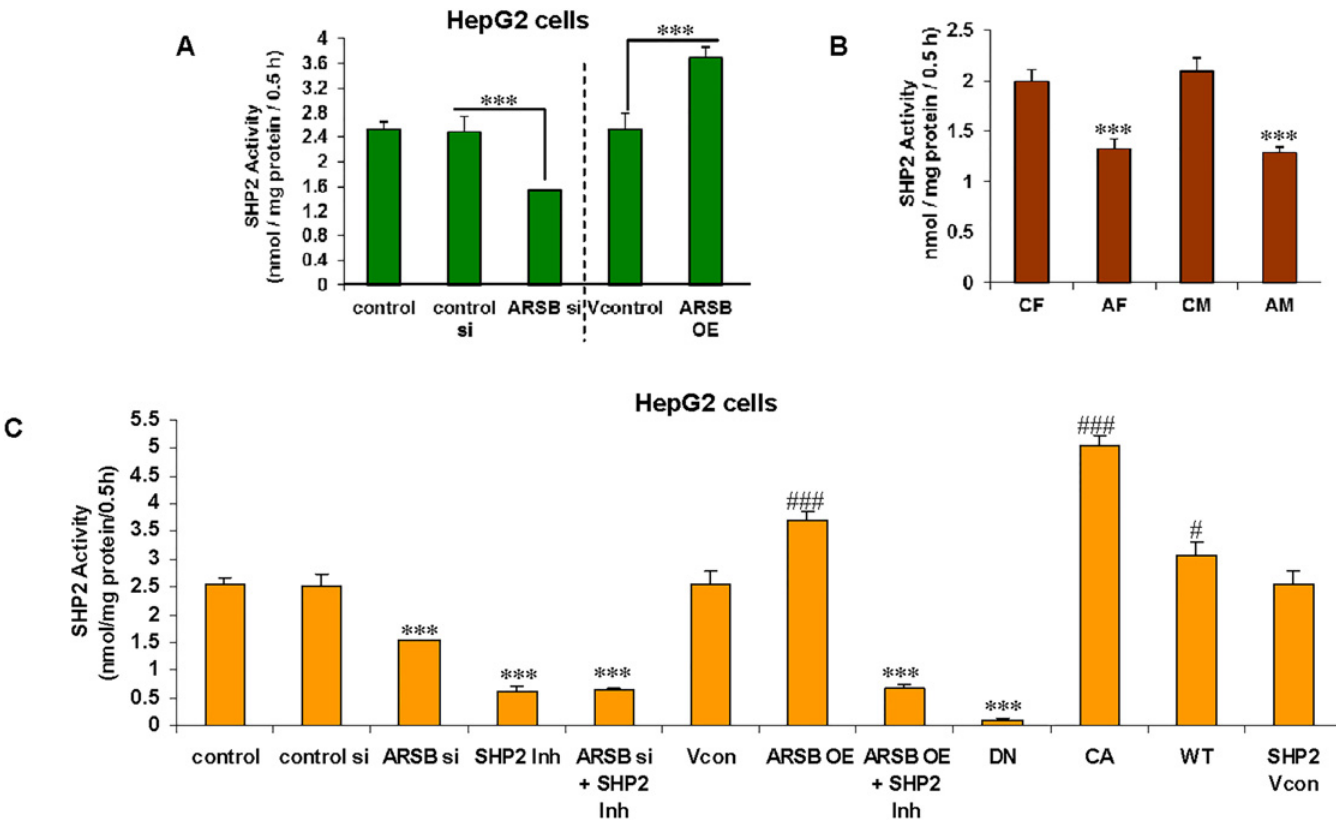
Fig 4. Decline in SHP2 activity follows decline in ARSB in HepG2 cells and in ARSB-null mice. (A) The SHP2 activity declined ~36% from (2.49 ± 0.15 nmol/mg protein/0.5 h to 1.59 nmol/mg protein/0.5h) following ARSB silencing (p < 0.001; n = 6), and increased to 3.70 ± 0.16 nmol.mg protein/0.5h when ARSB was overexpressed in the HepG2 cells (p < 0.001; n = 3). (B) SHP2 activity was markedly reduced in the ARSB-null mice (declining from 1.99 ± 0.12 to 1.33 ± 0.10 nmol/mg protein/0.5h, p = 0.001 (F); and 2.09 ± 0.13 to 1.28 ± 0.06 nmol/mg protein/h, p = 0.0006 (M), unpaired t-test, two-tailed; n = 3 per group). (C) The impact of different SHP2 DNA constructs on the SHP2 activity was tested. Constitutively active(CA)- and wild-type(WT)-SHP2 DNA increased the SHP2 activity (p < 0.001, p < 0.05), and dominant negative (DN)-SHP2 DNA inhibited the SHP2 activity (p < 0.001). ARSB siRNA, the SHP2 inhibitor PHSP1, and PHSP1 in combination with ARSB siRNA or with ARSB OE reduced the activity (p < 0.001; n = 3), in comparison to the controls. SHP2 activity in the CA was ~50 times greater than in the DN (5.04 ± 0.10 nmol/mg protein/0.5h vs. 0.10 ± 0.01 nmol/mg protein/0.5h). [AF = ARSB-null female; AM = ARSB-null male; ARSB = arylsulfatase B; CA = constitutively active; CF = control female; CM = control male; DN = dominant negative; OE = overexpression;si = siRNA; WT = wild-type; * for decrease; # for increase]